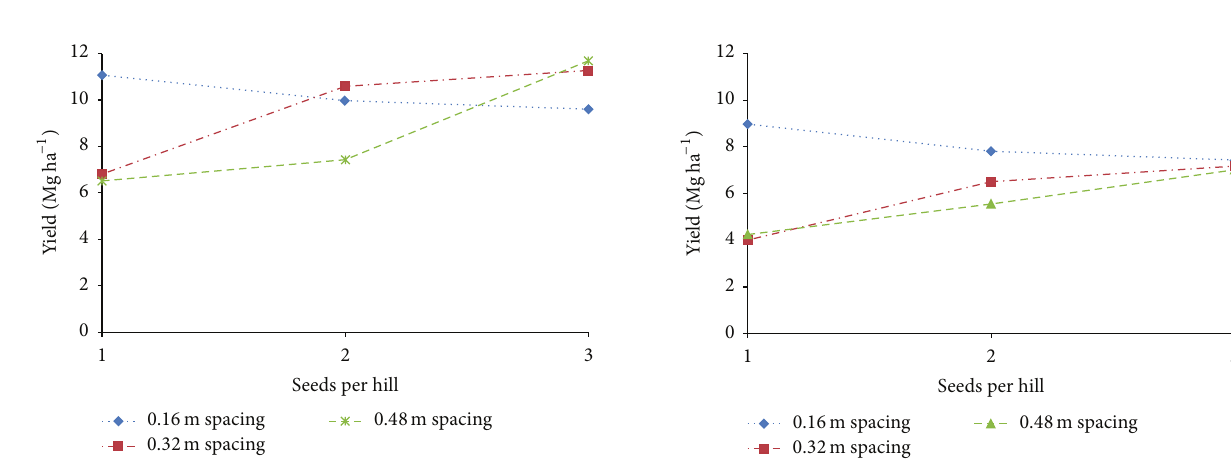
Figure 3: The interaction effects of plant spacing (0.16m, 0.32 m, and 0.48 m) and number of seeds per hill (1, 2, and 3) on grain yields (Mgha −1 ) averaged across replication at Efaw,